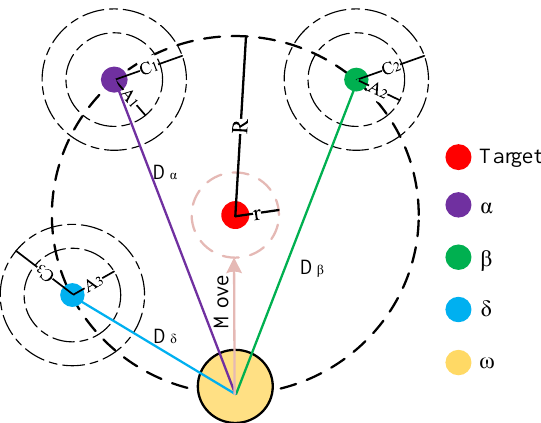
Figure 1. The diagram of gray wolf hunting.